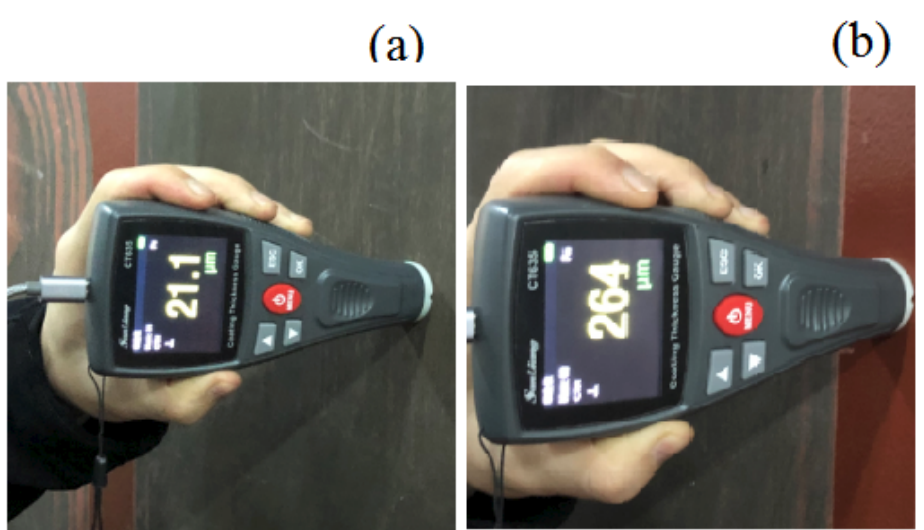
Figure 6. Coating thickness gauge ( a ) measurement of the residual coating thickness; ( b ) measurement of the initial coating thickness.